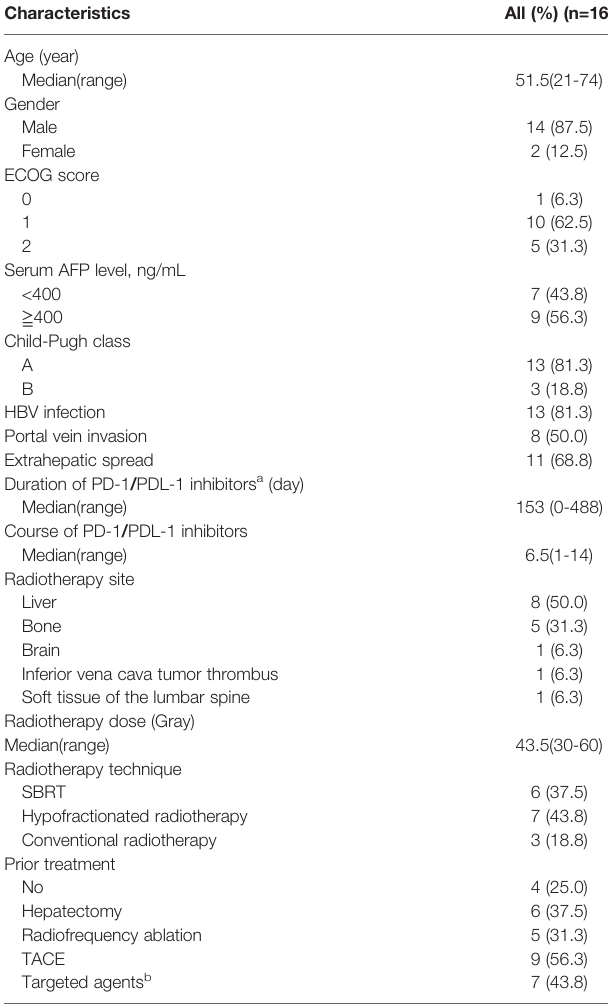
TABLE 1 | Patient characteristics and treatments.